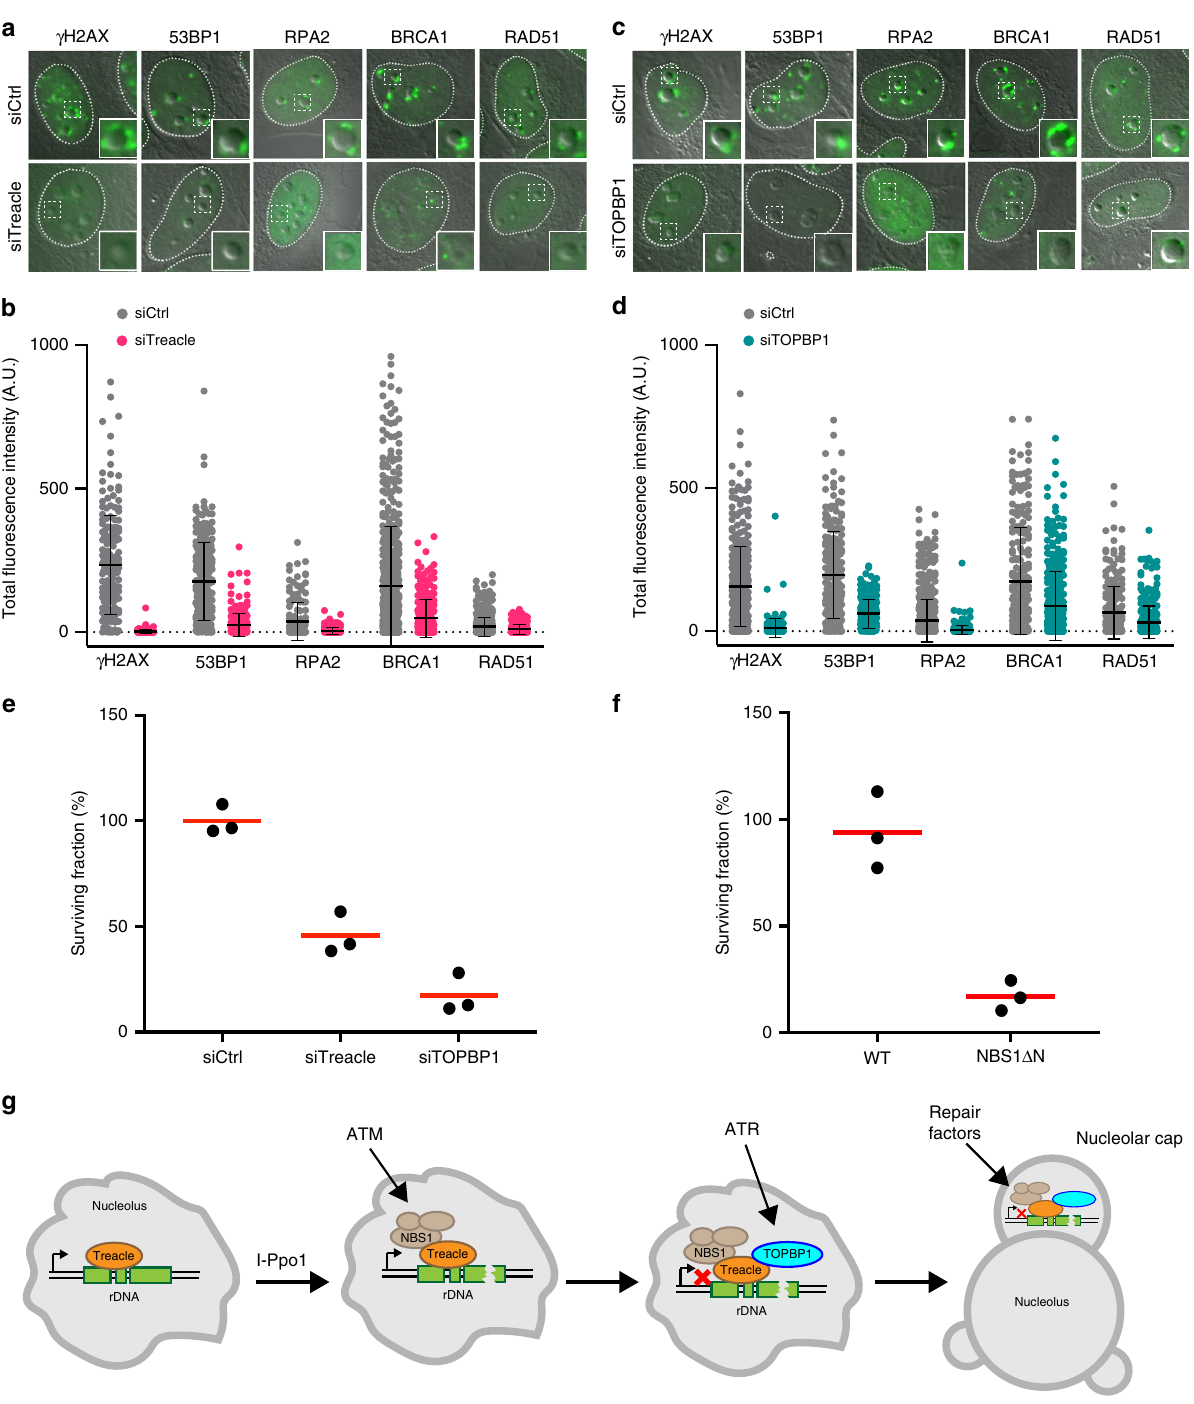
Fig. 8 Loss of Treacle and TOPBP1 impairs rDNA repair. a γ H2AX, 53BP1, RPA2, RAD51 and BRCA1 localization in control depleted (siCtrl) and Treacle- depleted (siTreacle) U2OS cells 2 h after I-Ppo1 transfection. b Quanti fi cation of the experiment in a , γ H2AX: siCtrl ( n = 177) versus siTreacle ( n = 200), 53BP1: siCtrl ( n = 261) versus siTreacle ( n = 239), RPA2: siCtrl ( n = 152) versus siTreacle ( n = 168) BRCA1: siCtrl ( n = 525) versus siTreacle ( n = 246) and RAD51: siCtrl ( n = 525) versus siTreacle ( n = 246) cells (all datapoints are shown, bar represents mean, error bars represent S.D.) c γ H2AX, 53BP1, RPA2, RAD51 and BRCA1 localization in control depleted (siCtrl) and TOPBP1-depleted (siTOPBP1) U2OS cells 2 h after I-Ppo1 transfection. d Quanti fi cation of the experiment in c , γ H2AX: siCtrl ( n = 403) versus siTOPBP1 ( n = 205), 53BP1: siCtrl ( n = 239) versus siTOPBP1 ( n = 256), RPA2: siCtrl ( n = 649) versus siTOPBP1 ( n = 359) BRCA1: siCtrl ( n = 228) versus siTOPBP1 ( n = 348) and RAD51: siCtrl ( n = 228) versus siTOPBP1 ( n = 348) cells (all datapoints are shown, bar represents mean, error bars represent S.D.). e Clonogenic surivival analysis of I-Ppo1-transfected control (siCtrl), Treacle-depleted (siTreacle) and TOPBP1-depleted (siTOPBP) U2OS cells (red bars represent the mean). f Clonogenic surivival analysis of I-Ppo1- transfected WT and NBS1DN U2OS cells (red bars represent the mean). g Model (see text for details). Source data are provided as a Source Data fi